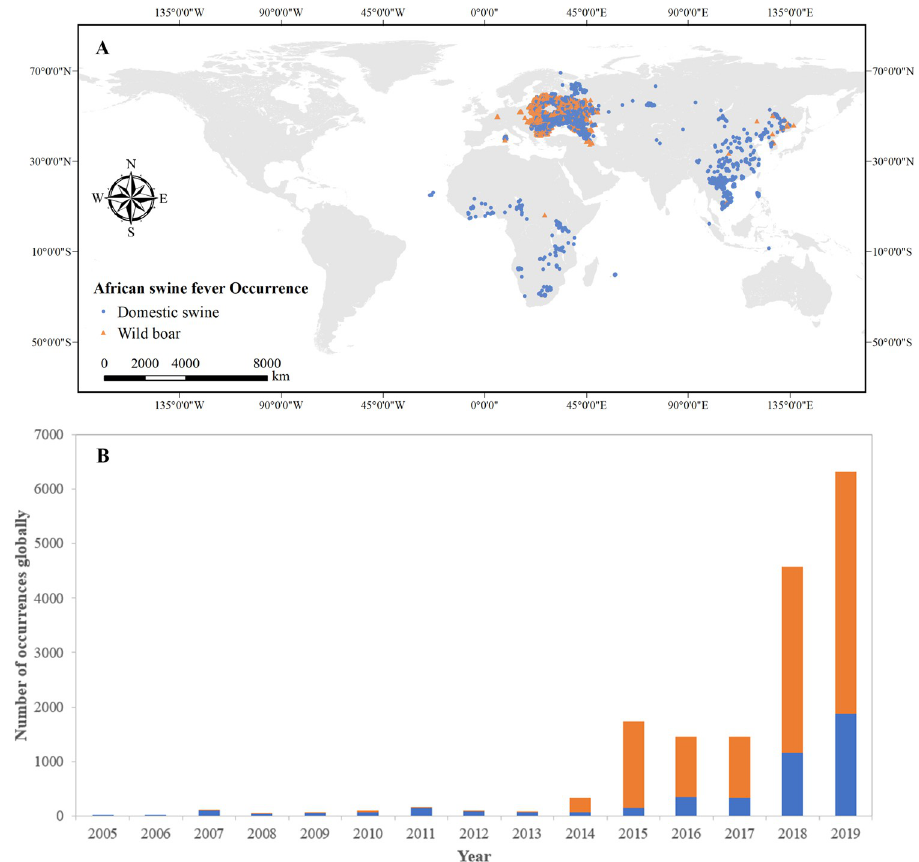
Fig 1. (A) The global distribution of 16,550 African swine fever cases from 2005 to 2019. Locations are classified by the type of pigs: domestic pigs (blue dots); and wild boars (yellow triangles). (B) The number of African swine fever cases globally over time